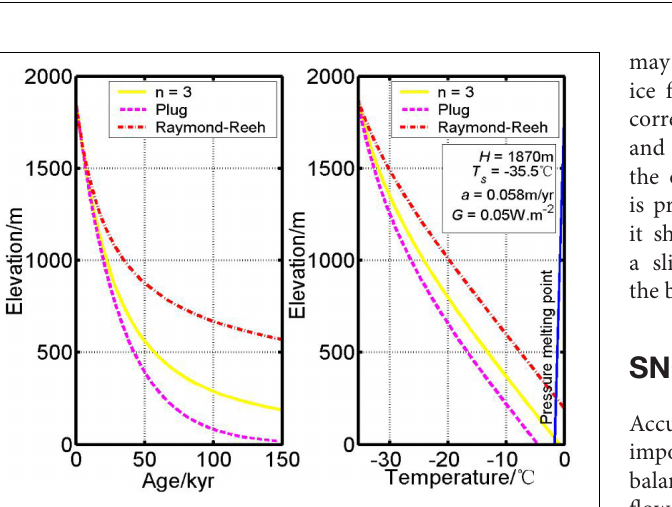
( Figure 2 ) during CHINARE 32nd on January 31,